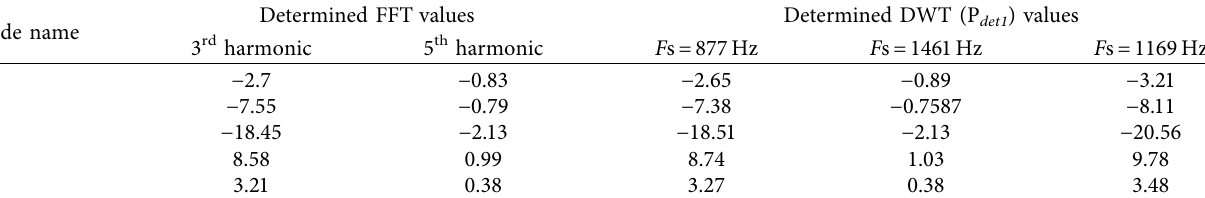
Table 5: The 3rd and 5th harmonic current generated by the load.